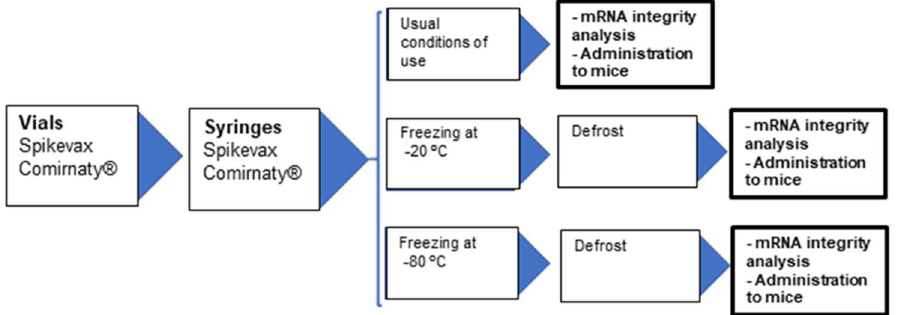
Figure 1. Summary of the protocol used for handling and re-freezing reconstituted Comirnaty ® and Spikevax ® COVID 19 vaccines.